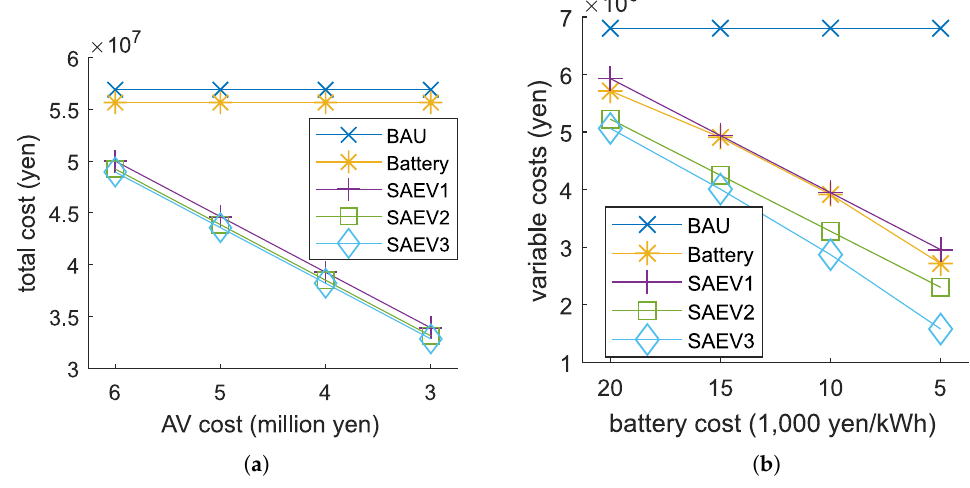
Figure 5. Sensitivity of: ( a ) Total costs to autonomous vehicle cost; and ( b ) Variable costs (electricity, fuel, and battery costs) to battery